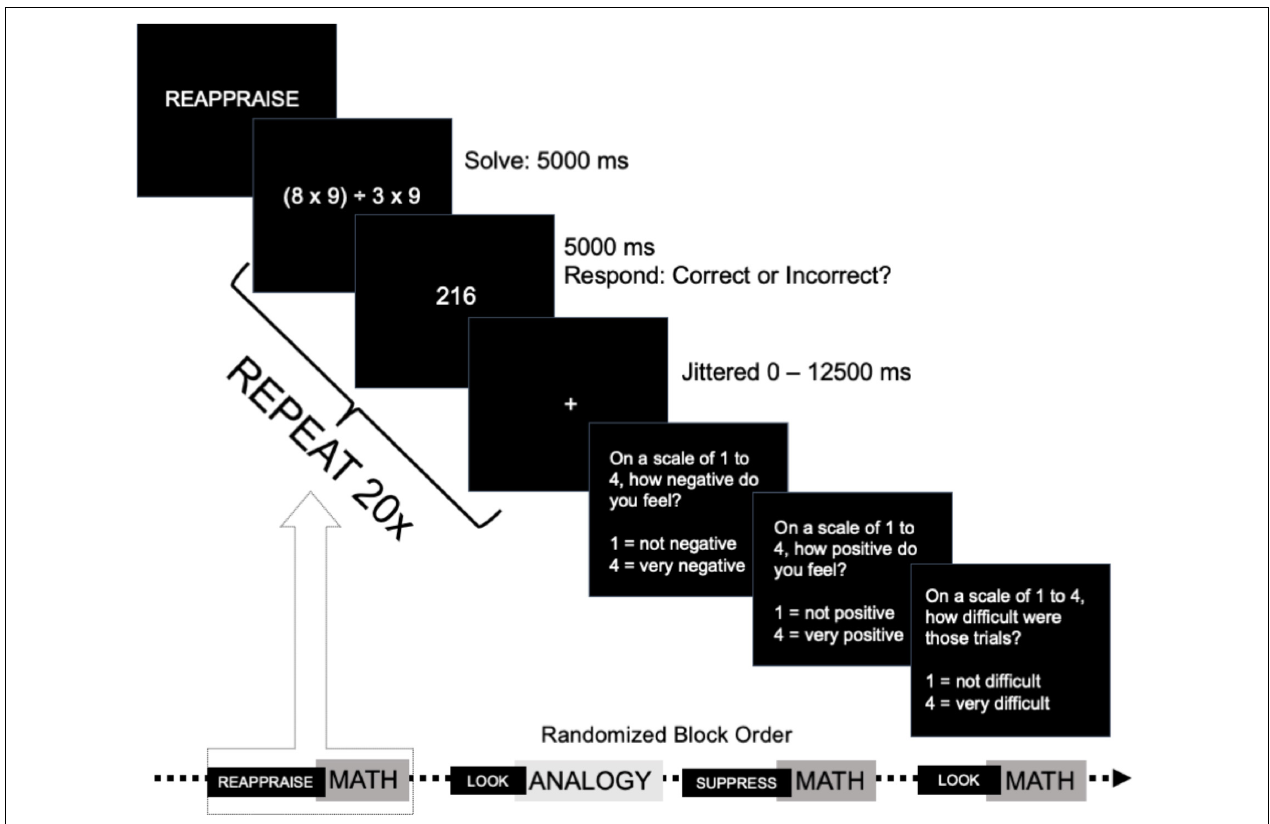
FIGURE 1 | Trial cadence and sample block sequence for Emotion Regulation task. Sequence of events during trials for emotion regulation task depicting a math problem in the CR condition. Participants saw an emotion regulation instruction at the start of each block of trials. Then, participants completed a short sequence of trials (math trials pictured above). Participants completed 20 unique trials of a single type during each block of trials (trial procedure repeated 20 × ). At the end of each block of trials, participants were asked to indicate their negative and positive feelings, as well as to rate the difficulty of that block of